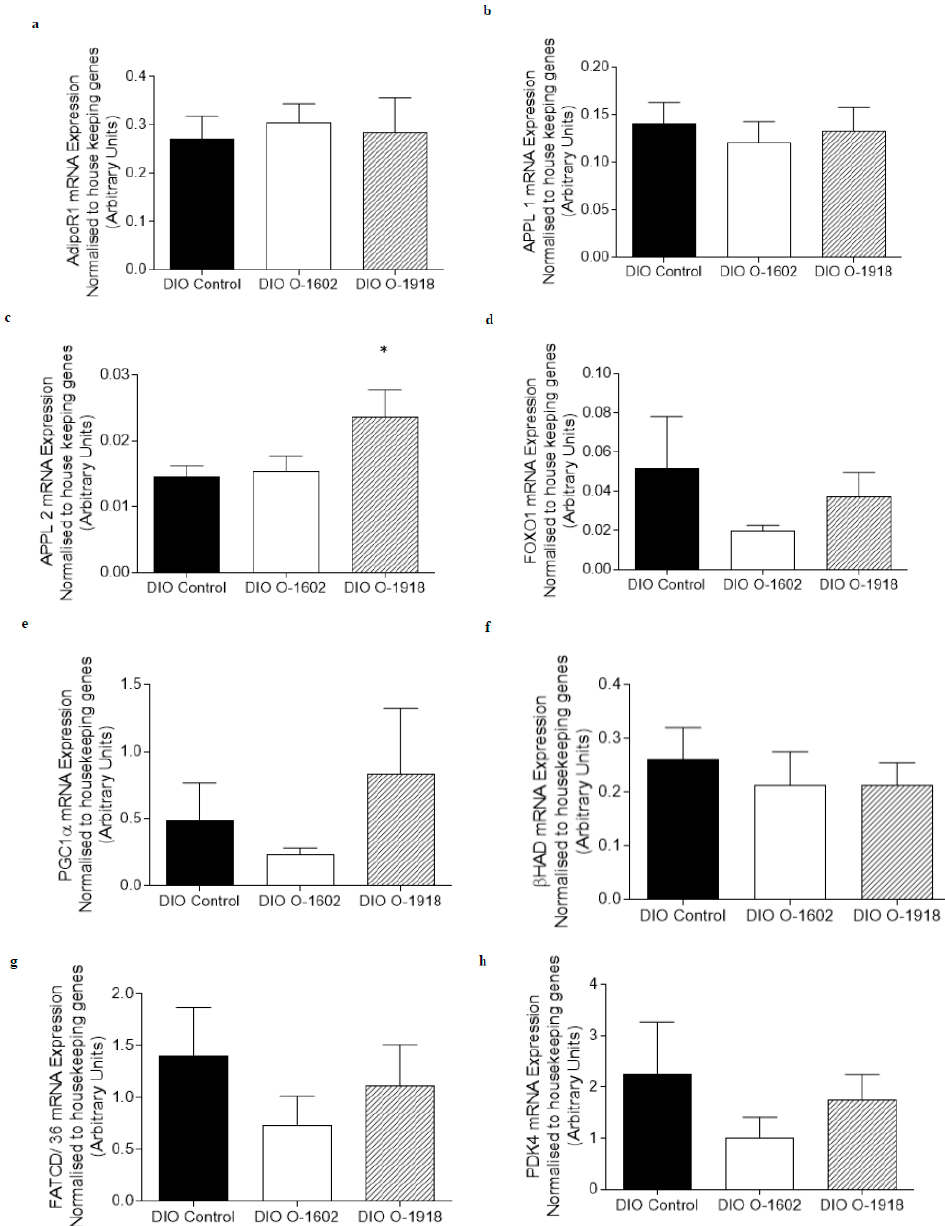
Figure 2. The abundance of mRNA expressed for markers involved in adiponectin signalling, fatty acid metabolism and oxidative capacity in white gastrocnemius skeletal muscle obtained from rats fed a high fat diet for 9 weeks to induce obesity. The DIO control rats, DIO O-1602 rats and the DIO O-1918 rats were treated via intraperitoneal injection for a further 6 weeks. mRNA expression was normalised to the average of housekeeping genes cyclophilin and β Actin and grouped data is reported as mean (arbitrary units) ± SEM. The DIO control group is compared to either the DIOO-1602 group (* significance p < 0.05) or the DIO O-1918 group (* significance p < 0.05). ( a ) Adiponectin Receptor 1 (AdipoR1); ( b ) Adaptor protein containing pleckstrin homology domain, phosphotyrosine binding domain and leucine zipper motif 1 (APPL1); ( c ) Adaptor protein containing pleckstrin homology domain, phosphotyrosine binding domain and leucine zipper motif 2 (APPL2); ( d ) Forkhead box protein 01 (FOXO1); ( e ) Peroxisome proliferator-activated receptor gamma co-activator 1 alpha (PGC1 α ); ( f ) beta-hydroxyacyl-CoA dehydrogenase ( β HAD); ( g ) Fatty Acid Translocase / Cluster of Di ff erentiation 36 (FATCD / 36); ( h ) Pyruvate Dehydrogenase Kinase 4